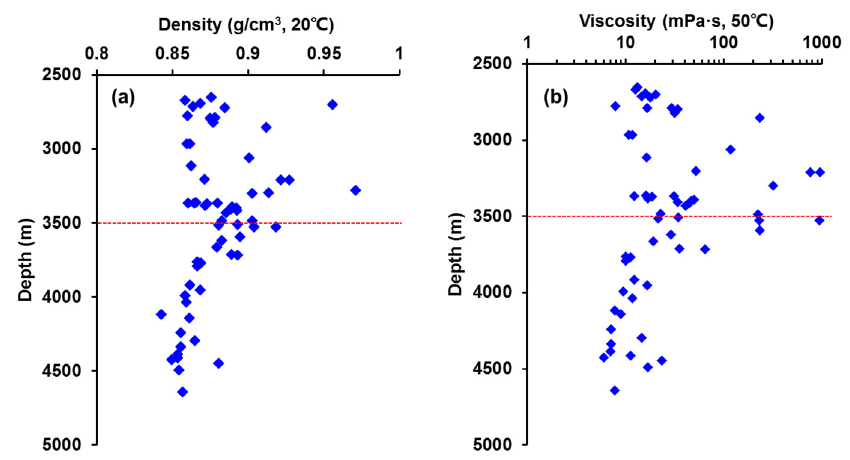
Figure 12. Relationships of density ( a ) and viscosity ( b ) of oil with burial depth.